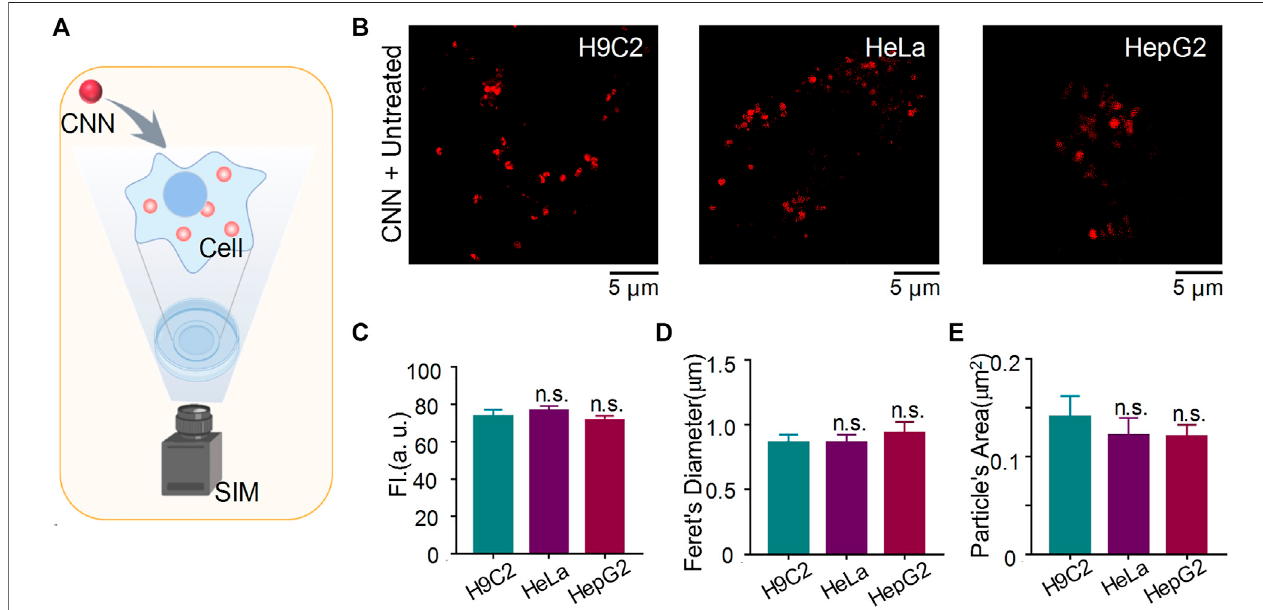
FIGURE 4 | CNN tracking lysosome in H9C2 cells, HeLa cells and HepG2 cells under SIM. (A) Imaging schematic of CNN in living cells. (B) SIM images of CNN (0.5 μ M, λ ex = 405 nm) in H9C2 cells, HeLa cells and HepG2 cells. (C – E) Fluorescence intensity, feret ’ s diameter and particle ’ s area of CNN in different cells. Data are shown as mean ± SEM ( n = 8; n.s. represents no statistical signi fi cance). All compared with untreated